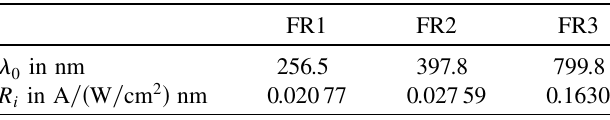
TABLE I. Filter radiometer parameters for FR1, FR2, and FR3 as derived from irradiance calibration. (cid:2) weighted mean wavelength and R responsivity (see